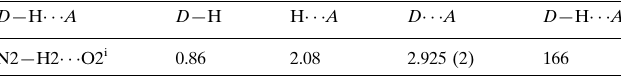
Hydrogen-bond geometry (A˚ , (cid:2)